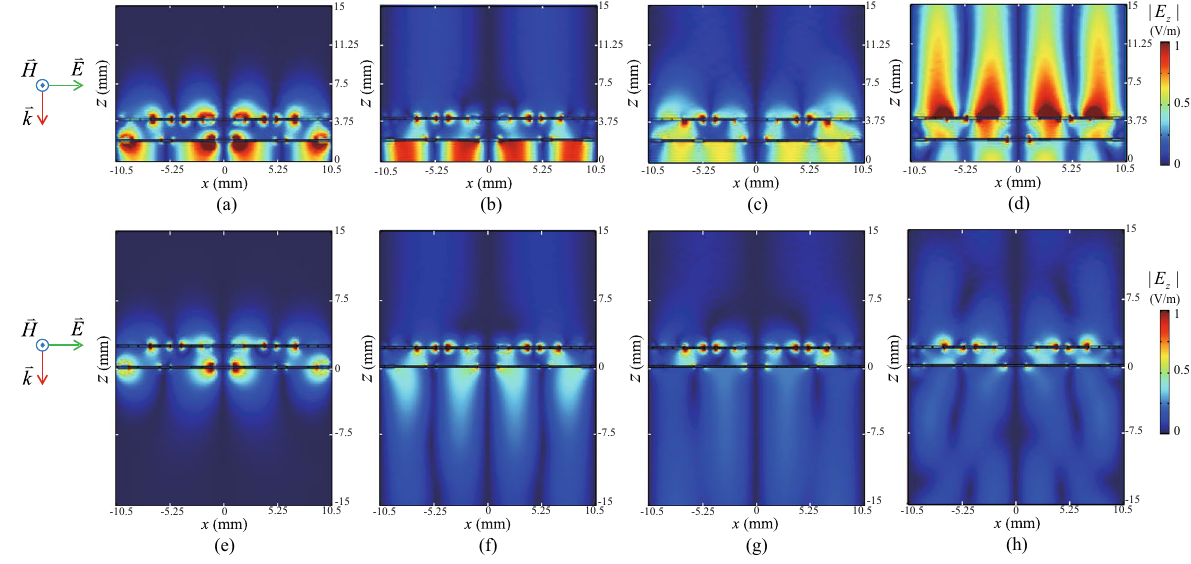
Figure 4. Magnitudes of electric field intensities along the z axis | E z | at y = − 5.25 mm with the perfect conductor (PEC) at the backside of the total structure at frequencies ( a ) 7.5 GHz, ( b ) 17.5 GHz, ( c ) 21 GHz, and ( d ) 28.5 GHz. | E z | at y = − 5.25 mm with a half-infinite acrylic medium without PEC at frequencies, ( e ) 7.5 GHz, ( f ) 17.5 GHz, ( g ) 21 GHz, and ( h ) 28.5